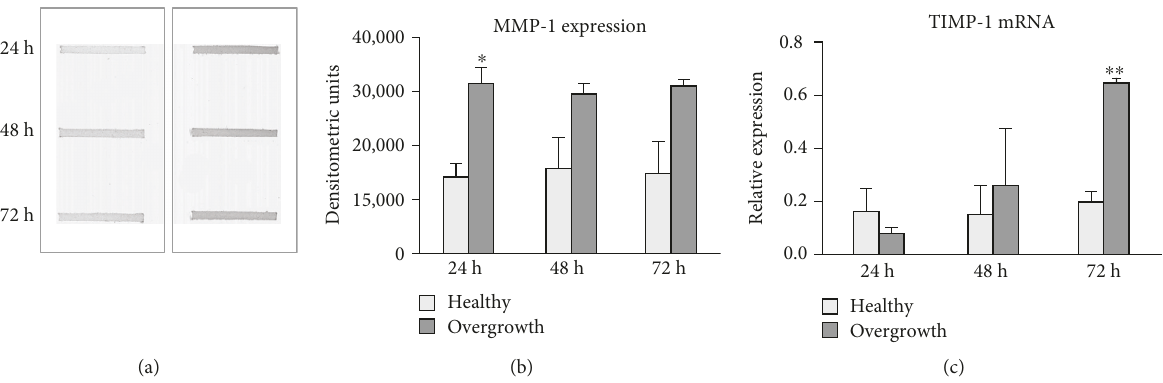
Figure 6: MMP-1 and TIMP-1 expression. (a) Representative slot blot showing MMP-1 levels in serum-free cell culture supernatants of fi broblasts from healthy and overgrown gingivae. Immunoreactive bands were quanti fi ed by densitometric scanning as described in Materials and Methods. (b) Bar graphs showing MMP-1 protein levels analyzed by slot blot. Data are expressed as densitometric units and are mean ± SD for samples run in duplicate. (c) Bar graphs showing TIMP-1 gene expression after normalization on GAPDH mRNA levels. Data are expressed as mean ± SD for samples run in triplicate. ∗ p < 0 05 and ∗∗ p < 0 001 .